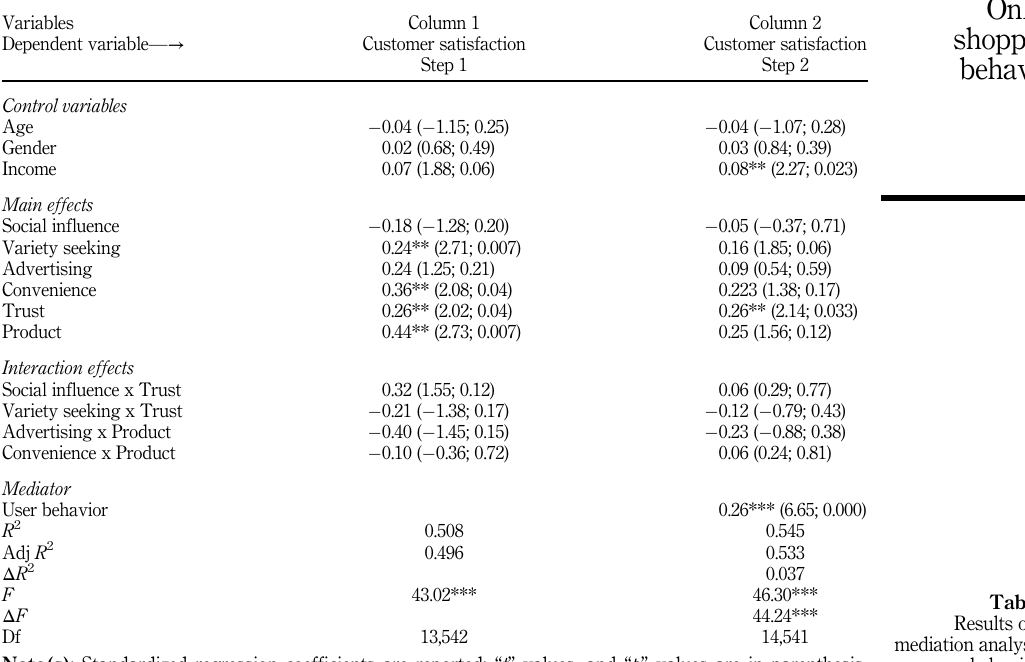
Table 6. Results of